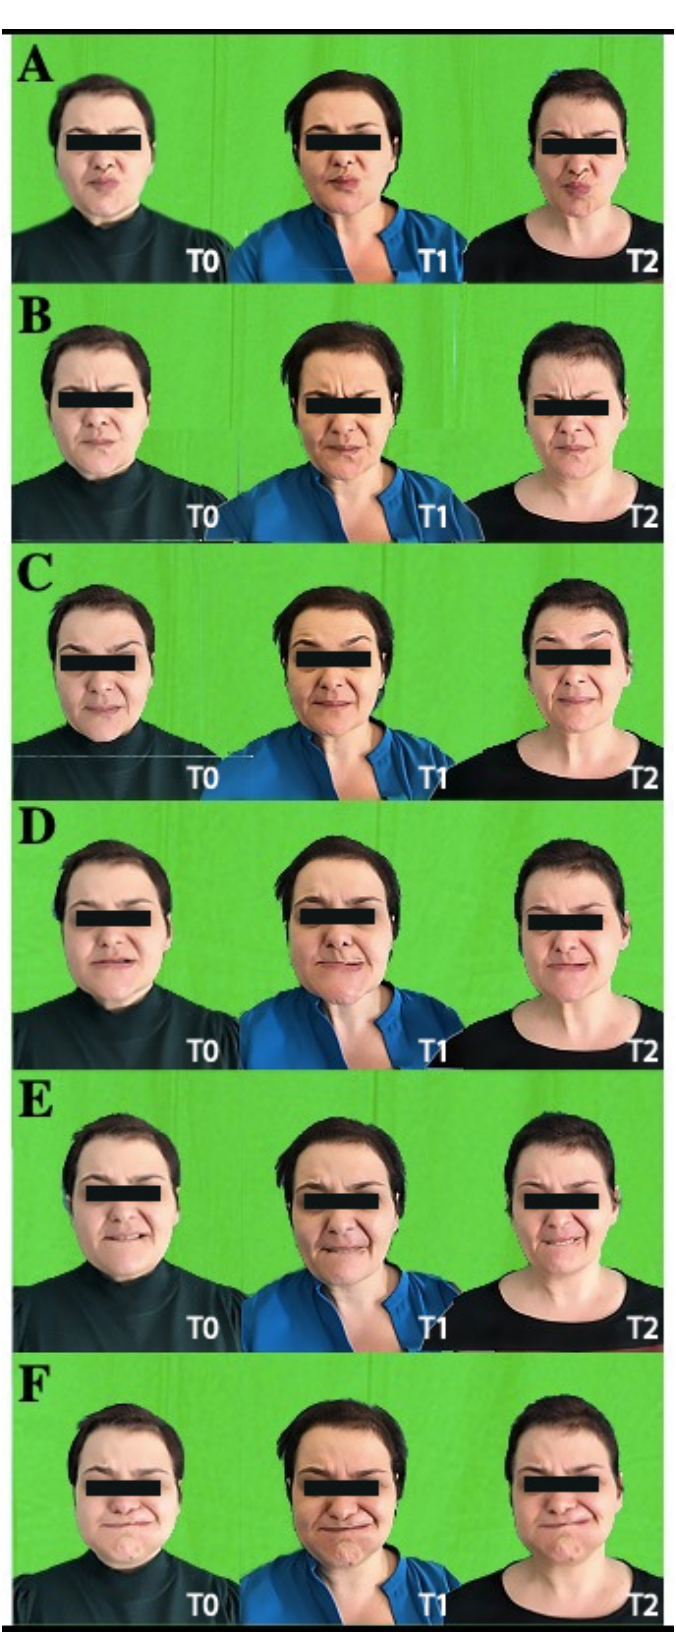
Figure 2. Movements executed by the patient during the examination to evaluate facial palsy at the different time-points from the left to the right: T0 (baseline), T1 (after 5 weeks), and T2 (at the end of treatment). ( A ): kiss with closed lips; ( B ): wrinkle the forehead; ( C ): elevate eyebrows; ( D ): bite the upper lips; ( E ): bite the lower lips; ( F ): puff up the cheeks.